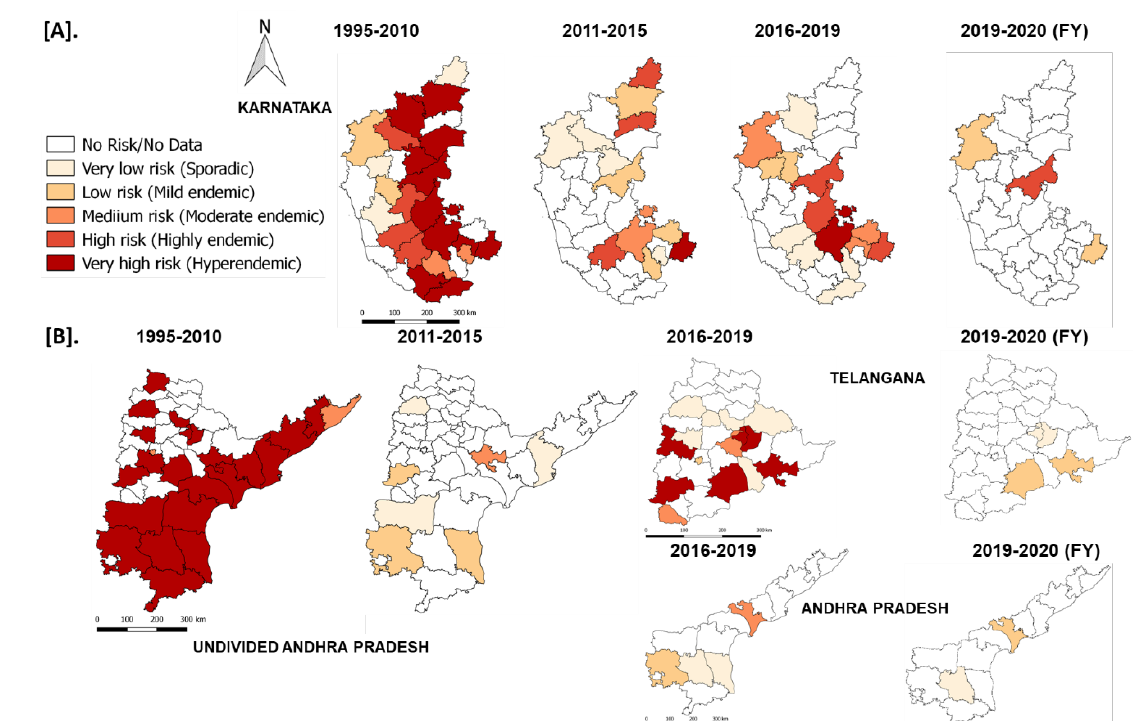
Figure 12. The reported outbreaks in different categories of endemic districts of Karnataka ( A ) Andhra Pradesh ( B ) with risk areas are depicted in six scales at different periods of analysis using QGIS-2.18 in the maps of the respective states. The endemicity categorization is based on the scale of the cumulative outbreaks, that occurred in the districts per year in the given period of analysis and classified into different risk level (if the outbreaks numbers in the district as 0–no risk, 1- very low, 2- low, 3- medium, 4- high and >4 very high-risk districts).